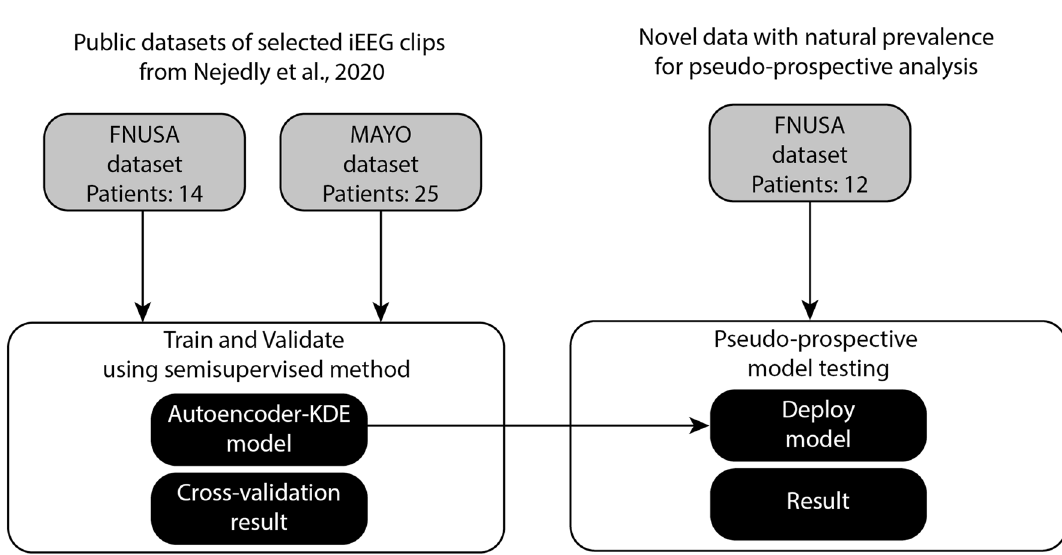
Figure 2. Description of the dataset used in this study. The datasets from Nejedly et al. 2020 were used for model training and validation. Novel data from 12 patients from FNUSA hospital were used for pseudo- prospective